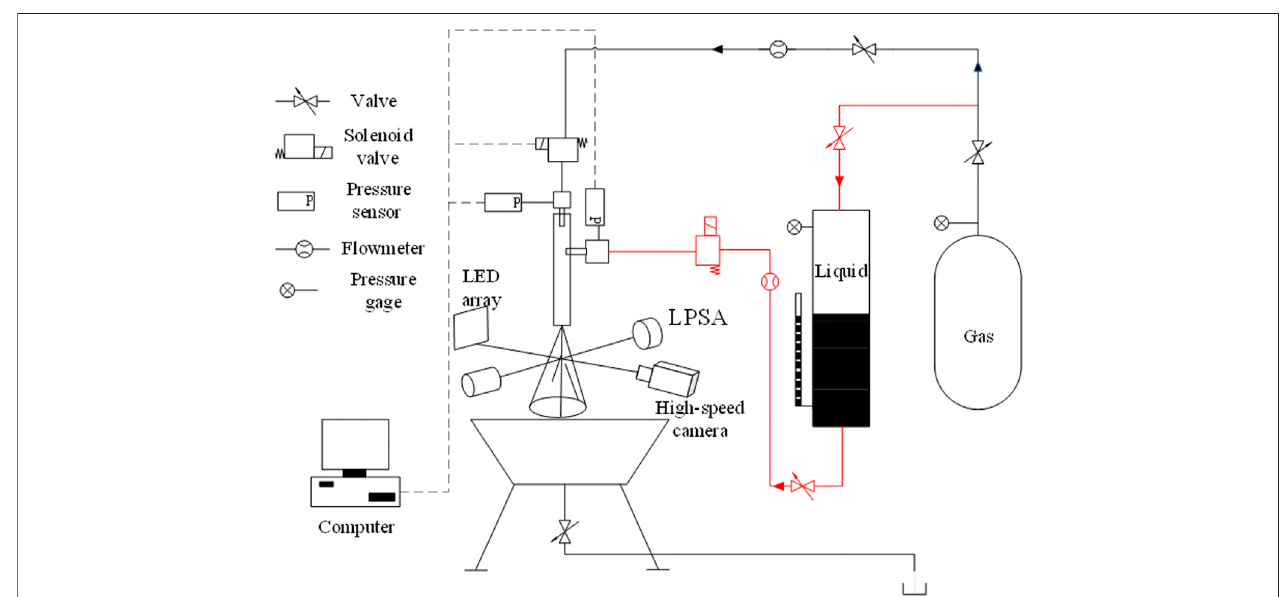
FIGURE 2 | Experimental